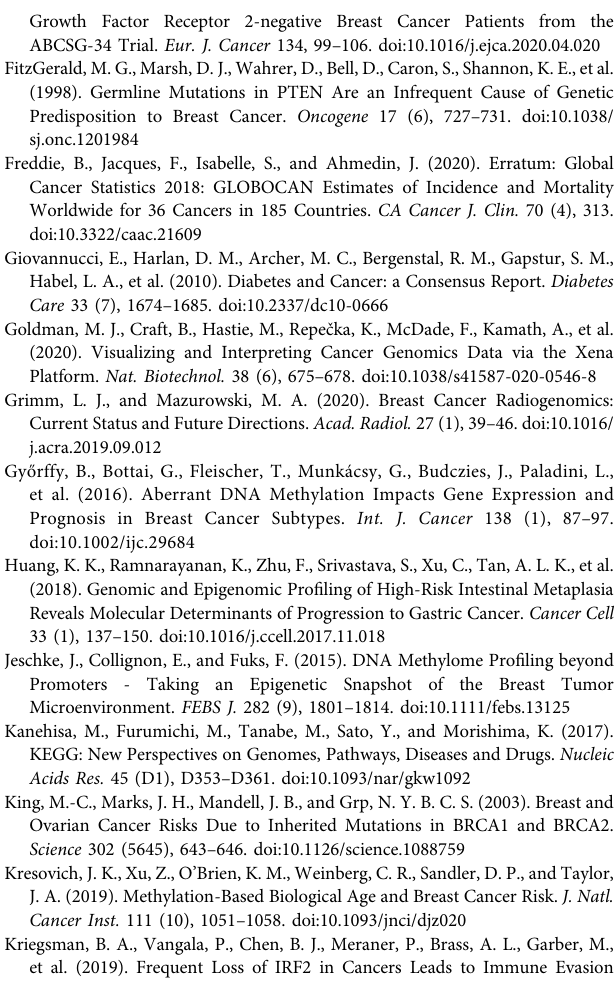
Supplementary Figure S3 | Survival analysis of the six signature genes. Supplementary Figure S4 | (A – I) The association of the methylation prognostic model and the gene prognostic signature. (A) The correlation of the six signature genes and the six signature CpGs. (B – G) The correlation between the β value of the six CpGs and the gene risk scores. (H) The correlation between methylation risk scores and gene risk scores. (I) The correlation of the methylation prognostic model and gene prognostic model. Supplementary Figure S5 | (A – I) (A) The expression of the 6 signature genes between gene high-risk and low-risk groups of 986 breast cancer samples; (B – E) Validation of the gene prognostic signature in a BRCA-TCGA subgroups composed of 557 samples, (B) Survival analysis, (C) ROC curve, (D) Univariate Cox regression analysis, (e) Multivariate Cox regression analysis; (F – H) Survival analysis in the other two BRCA-TCGA subgroups and the GSE146558 dataset, (F) survival analysis in the subgroups composed of 494 samples, (G) Survival analysis in the subgroups composed of 492 samples, (H) Survival analysis in the GSE146558 dataset; (I – K) ROC curves in the other two BRCA-TCGA subgroups and the GSE146558 dataset, (I) ROC curve in the subgroups composed of 494 samples, (J) ROC curve the subgroups composed of 492 samples, (K) ROC curve in the GSE146558 dataset. Supplementary Figure S6 | The overall survival analysis of breast cancer patients with different clinical characteristics in gene high-risk and low-risk groups.